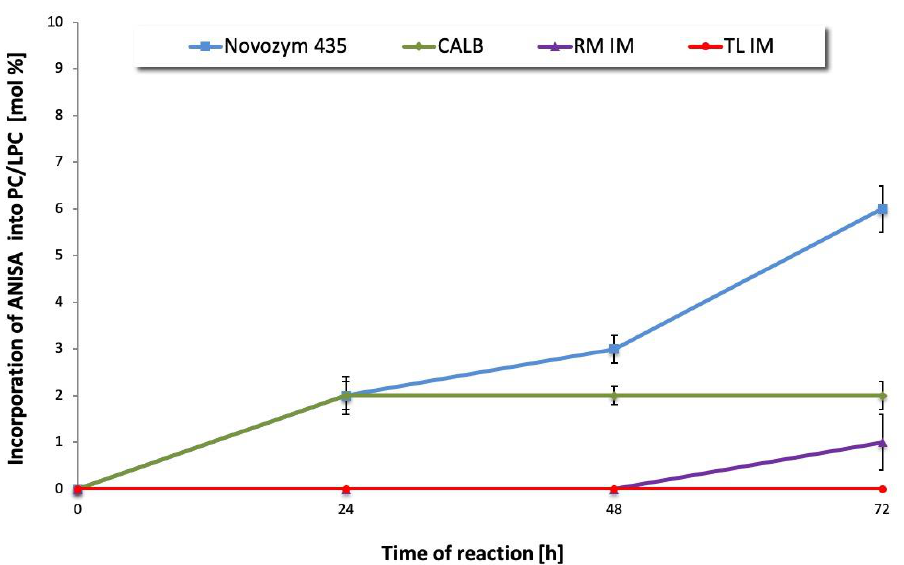
Figure 1. Time course of different lipase-catalyzed acidolysis between egg-yolk PC and ANISA (reaction conditions: 1:5 PC/ANISA molar ratio, solvent: heptane 2 mL, enzyme load 30% (w/w), temperature 50 °C). Vertical bars represent SD, n = 3.